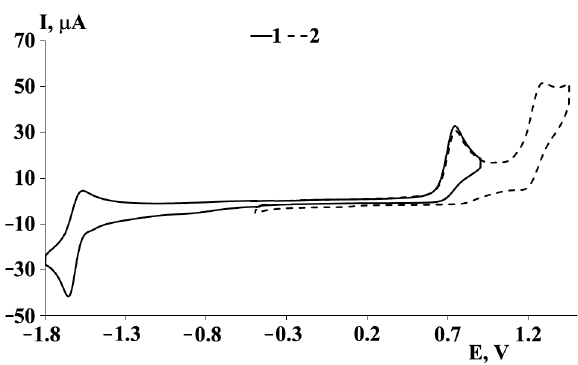
Figure 7. Cyclic voltammograms of 7 : the potential switch from − 1.80 to 0.90 V (curve 1); the potential switch from − 0.50 to 1.45 V (curve 2) (CH 2 Cl 2 , C = 2 mmol, 0.1 M TBAP, scan rate 200 mV ∙ s − 1 ).